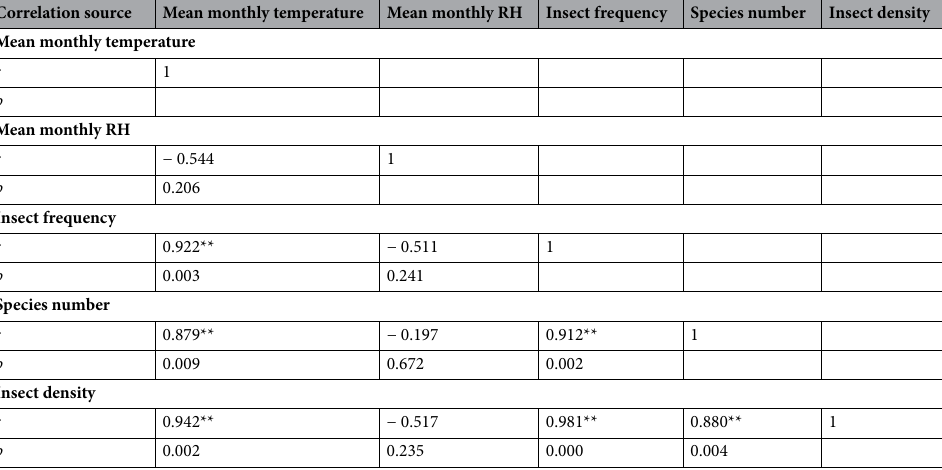
Table 6. Correlation between the species of Buprestidae family and environmental factors. **Correlation is significant at 0.01. r: Correlation coefficient p : Significance level. r: 0.00 No correlation. 0.01–0.29